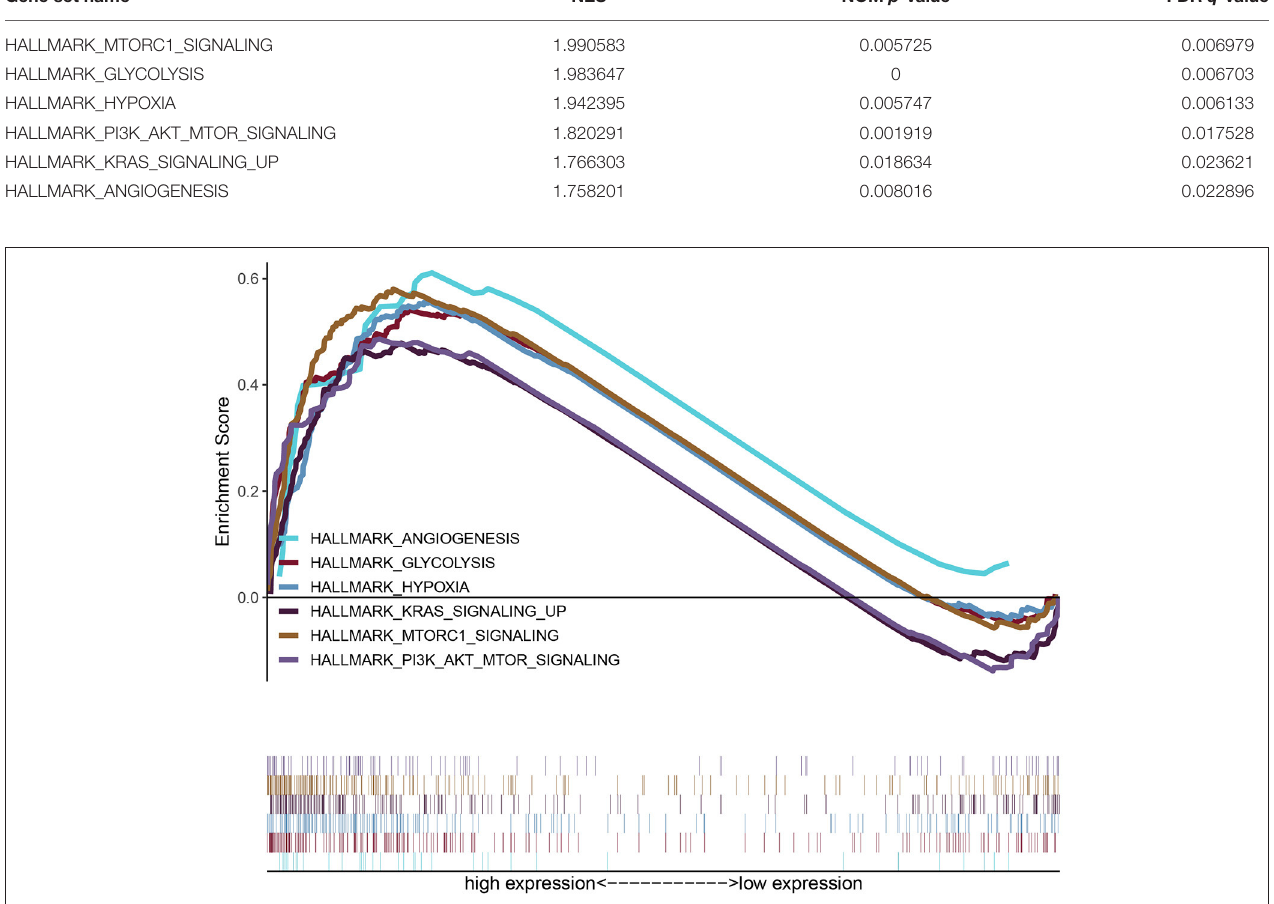
FIGURE 5 | Enrichment plots from GSEA of PYGL. GSEA results showing differential enrichment of genes related to MTORC1 signaling, glycolysis, hypoxia, PI3K/AKT/mTOR signaling, KRAS signaling up and angiogenesis in glioma cases with high PYGL expression.